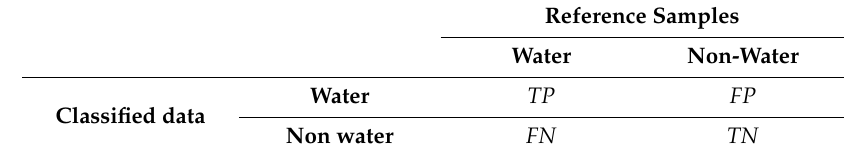
Table 3. Confusion matrix.